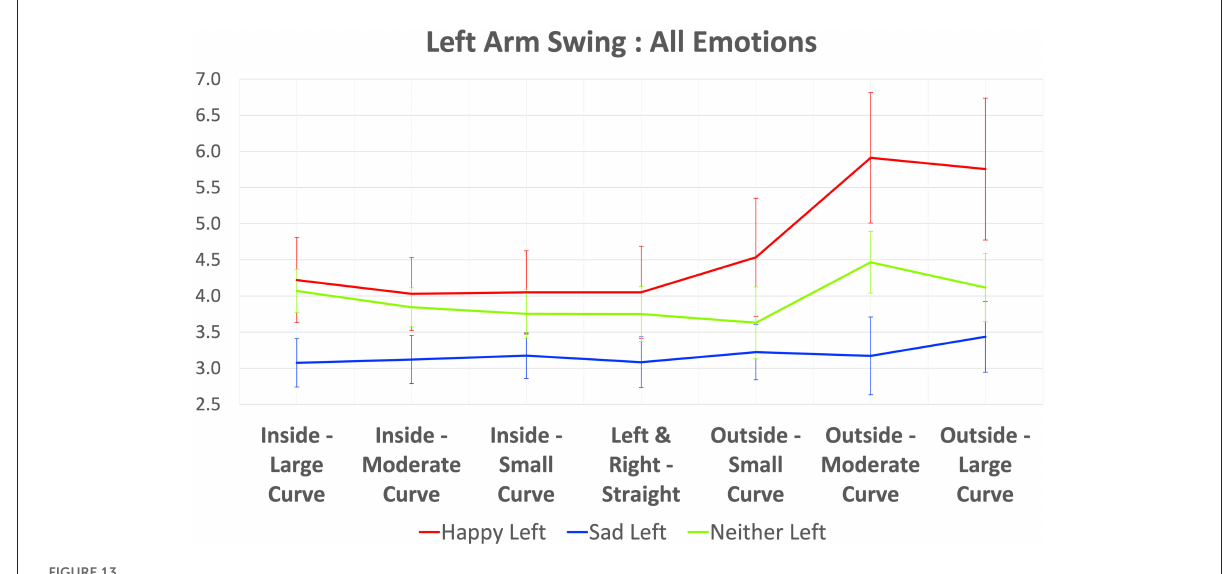
FIGURE13 Plot of left arm swing in all emotions (with 95% confident interval error bars).